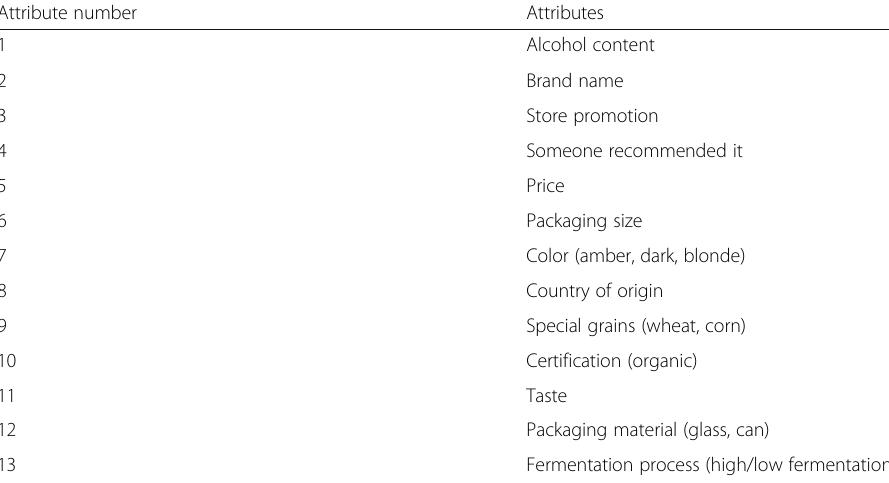
Table 1 Craft beer attributes considered by consumers when purchasing a beer Attribute